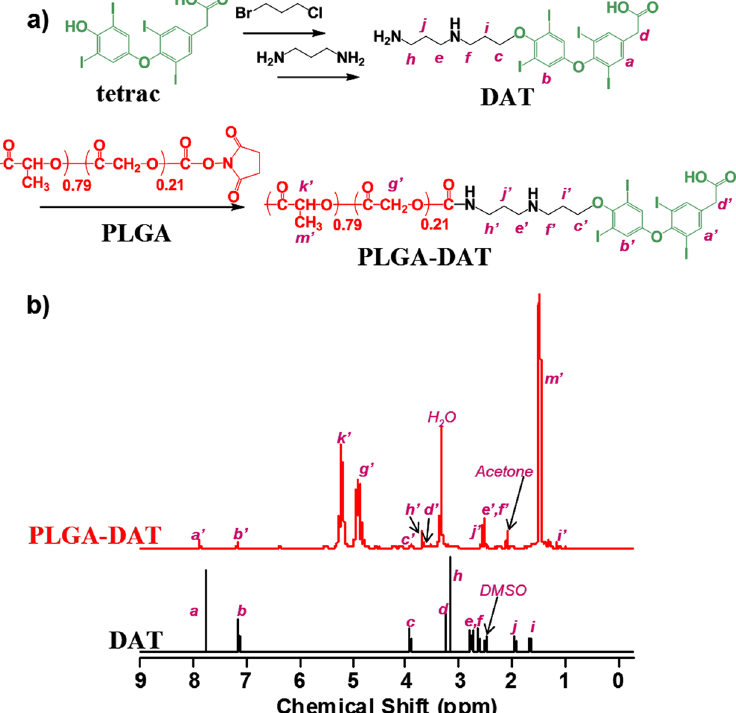
Figure 1. ( a ) Chemical structure and schematic illustration of the synthesis of diamino tetraiodothyroacetic acid (DAT)-conjugated PLGA (lactide:glycolide 79:21). ( b ) 1 H NMR spectra in DMSO-D6 and assignments of signals of DAT (bottom) and PLGA-DAT